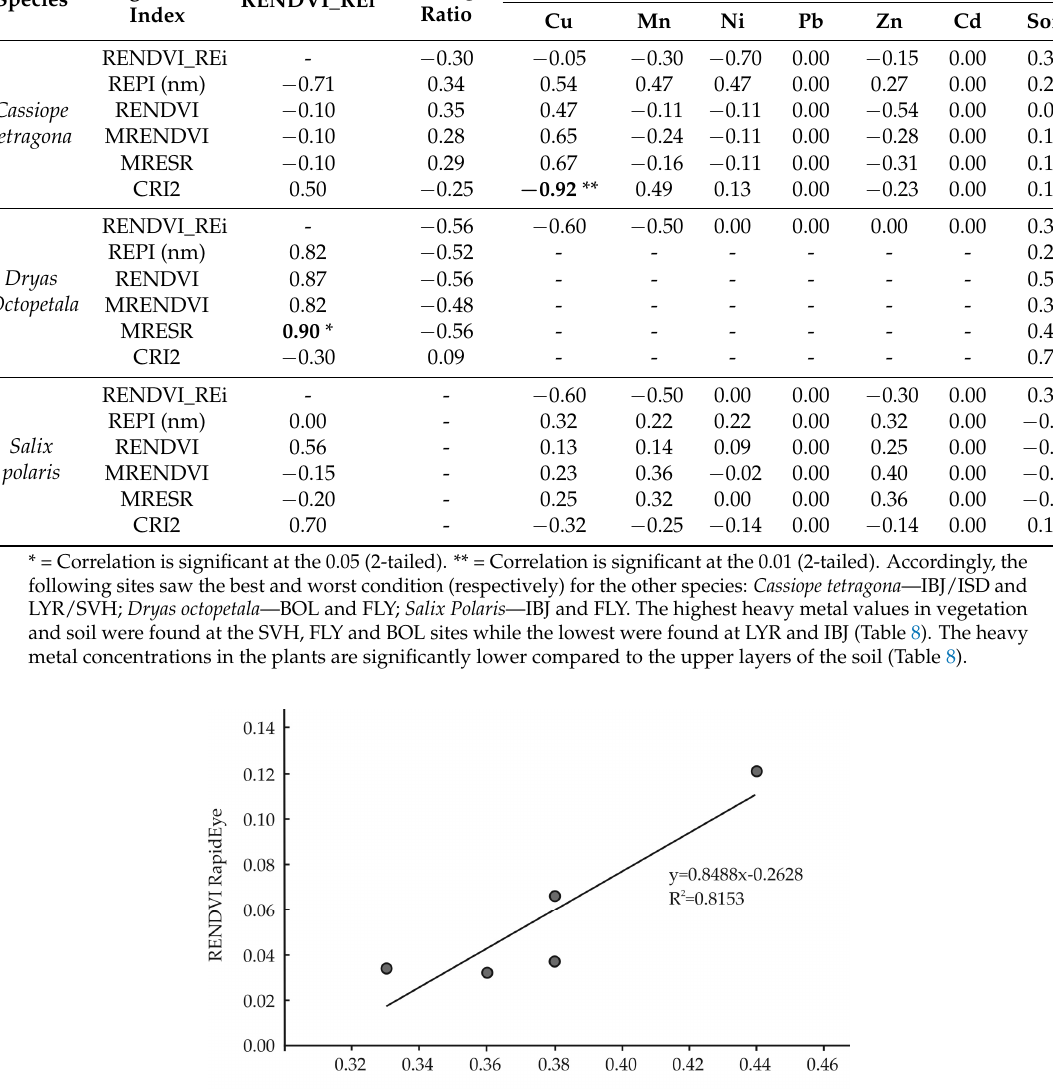
Figure 4. The relationship between the Red Edge NDVI (RENDVI) extracted from the RapidEye satellite image and the field-acquired (ASD FieldSpec) RENDVI for the species D. octopetala was analyzed for large homogenous plots without any other components, e.g., large stones/rocks or dry roots that could change the signal detected by the satellite sensor. Each point represents an individual measurement plot with BOL, IBJ, ISD, LYR and SVH included (Table 8).